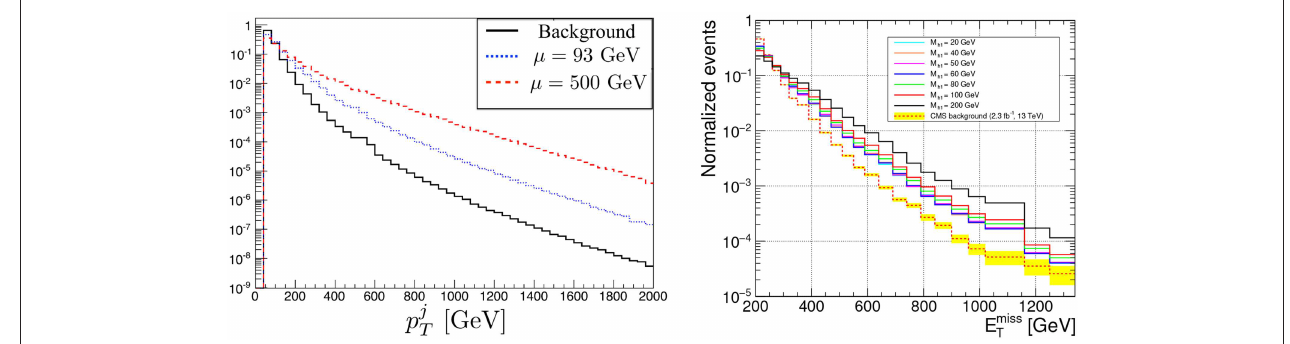
FIGURE 4 | (Left) Normalized signal (dotted blue and dashed red) and Zj background (solid black) parton-level p j T distributions for the 13 TeV LHC for the NSUSY scenario: normalized signal and Zj background distributions. See details in Barducci et al. [32]. (Right) Normalized E miss T from h 1 h 2 j i2HDM signal vs. background for √ s 13 TeV. See details in Belyaev et al. [33]. =